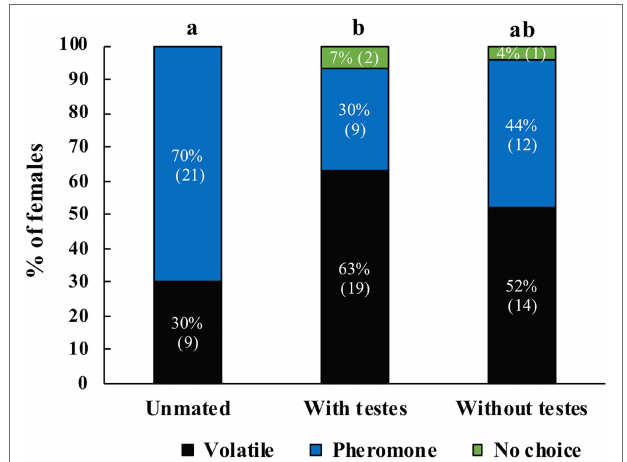
FIGURE 6 | Response of unmated A. obliqua females ( N = 30), mated with intact males ( N = 30), or mated with testectomized males ( N = 27) to host volatiles or male pheromone. Different letters indicate significant differences between treatments at the 0.05 level. Numbers within parenthesis represent sample